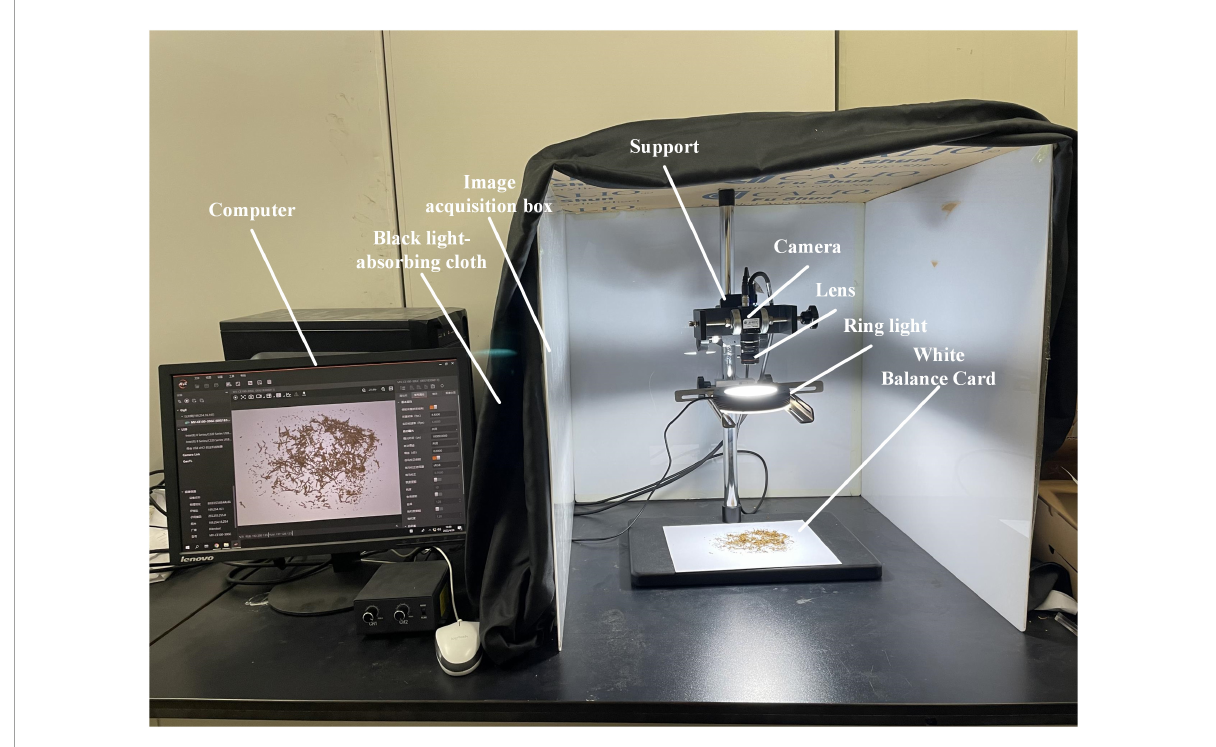
FIGURE3 Image acquisition